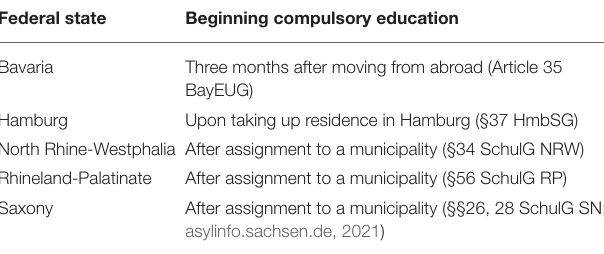
TABLE 1 | Beginning of compulsory